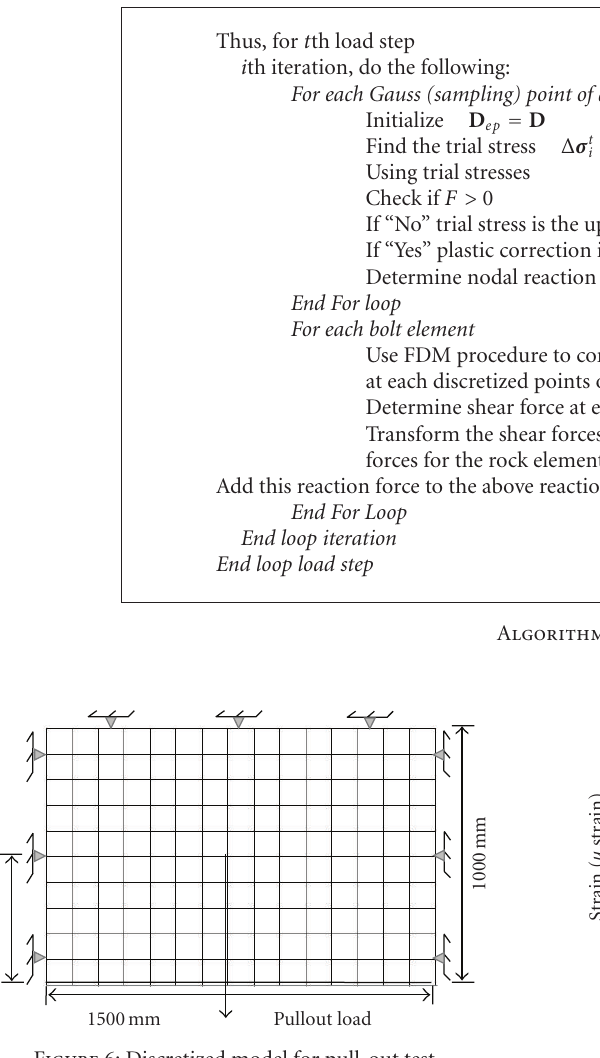
Figure 6: Discretized model for pull-out test.